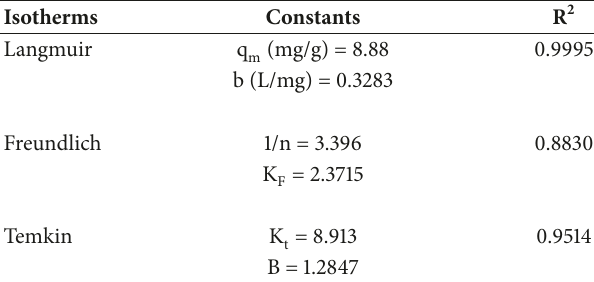
Table 1: Isotherm parameters for adsorption of Mg 2+ ions onto CTNTs